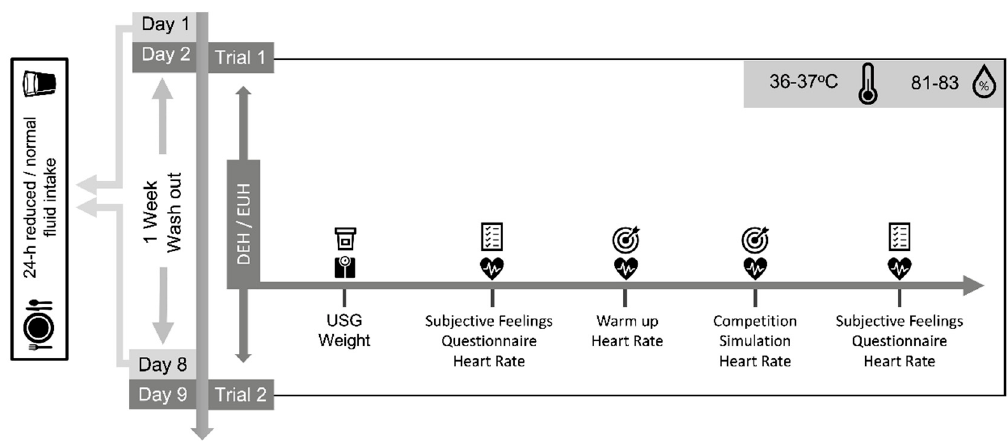
Figure 1. Overview of study design. DEH: Dehydration; EUH: Euhydration; USG: Urine Specific Gravity.